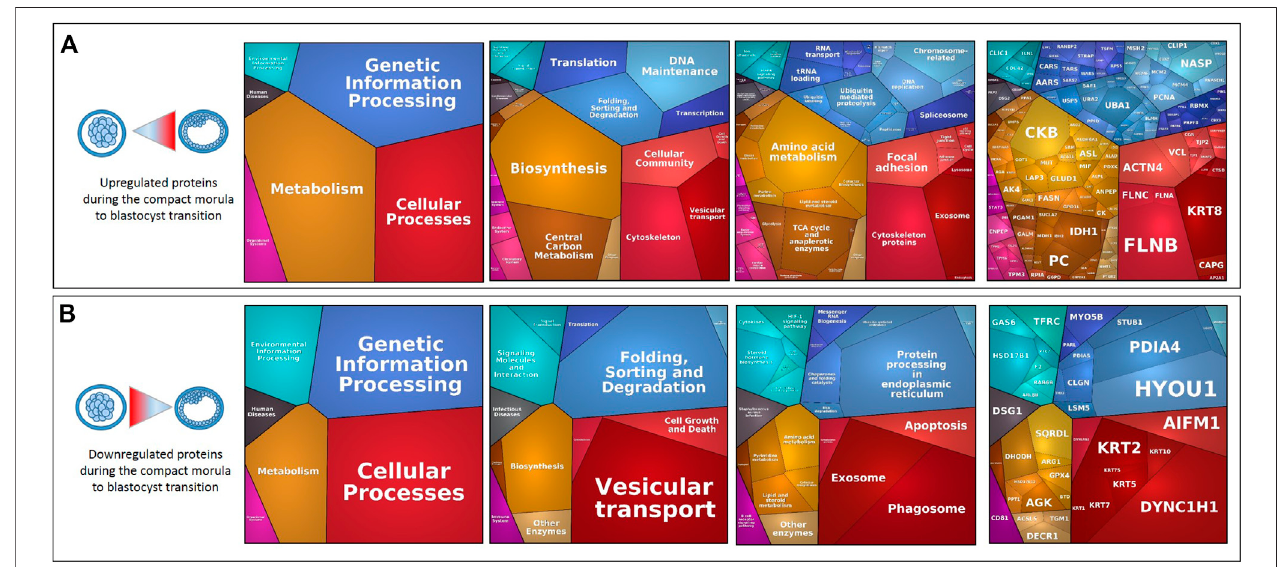
FIGURE9| Proteomapsofdifferentiallyabundantproteins(DAPs)duringthecompactmorula-to-blastocysttransition.Proteomapswerecarriedoutusingthelists of gene names of proteins increasing [ (A) , upper panels] or decreasing [ (B) , down panels] in abundance (t-test p-value ≤ 0.05; min fold-change of 2) between the compact morula and blastocyst stages and based on the KEGG Pathway gene classi fi cation. Functional categories (left and middle panels) and related proteins (right panel) are shown by polygons. Areas of polygons illustrate protein abundance, weighted by protein size. Functionally related functions/proteins are arranged in common regions and coded using similar colors.